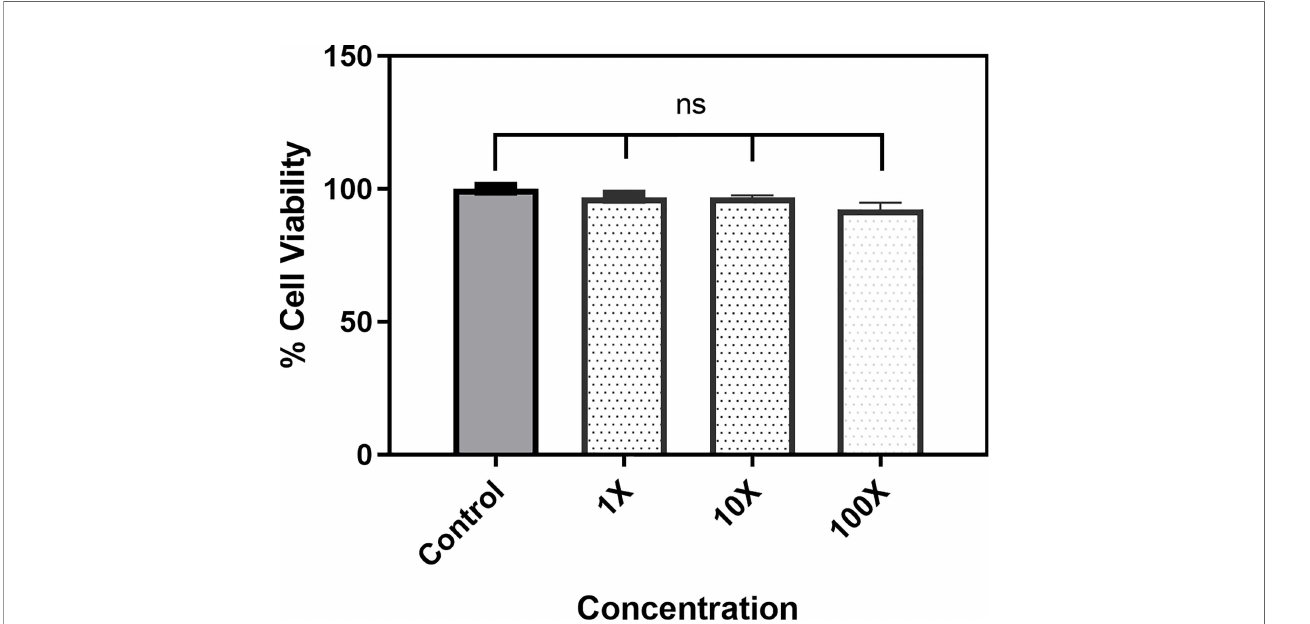
FIGURE 6 | Cytotoxicity assay. The bar graph depicts the viability of the Hep-G2 in the presence of 1X, 10X, and 100X of the 5-NPPP. ns, non-signi fi